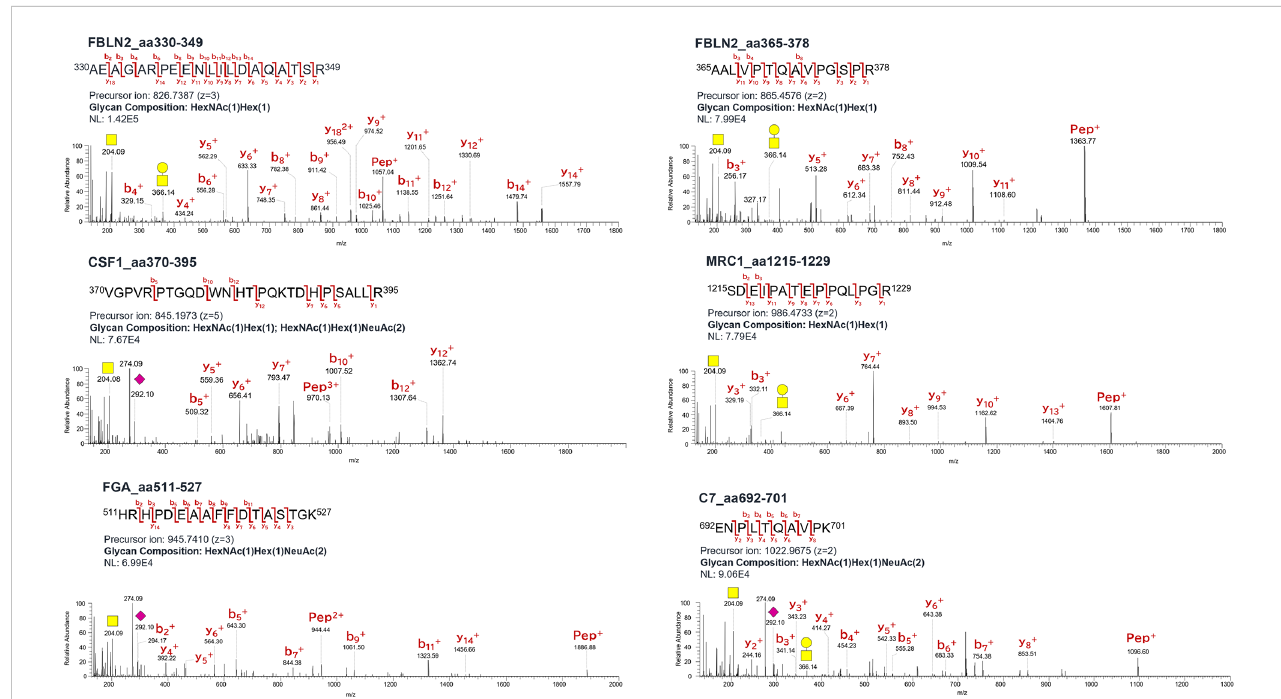
FIGURE 5 Product ion spectra of O-glycopeptides. Symbols: yellow circle, galactose; yellow square, N -acetylgalactosamine; purple diamond, N -acetylneuraminic acid; Hex, hexose; HexNAc, N -acetylhexosamine; NeuAc, N -acetylneuraminic